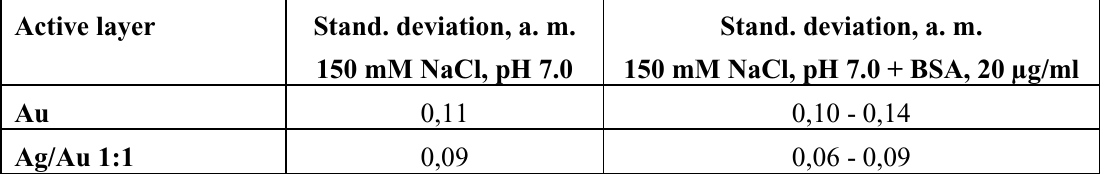
Table 3. Standard deviation of the resonance angle measured on different resonance phases: an application for investigation of adsorption or as an affinity biosensor. Active layer Stand. deviation, a.